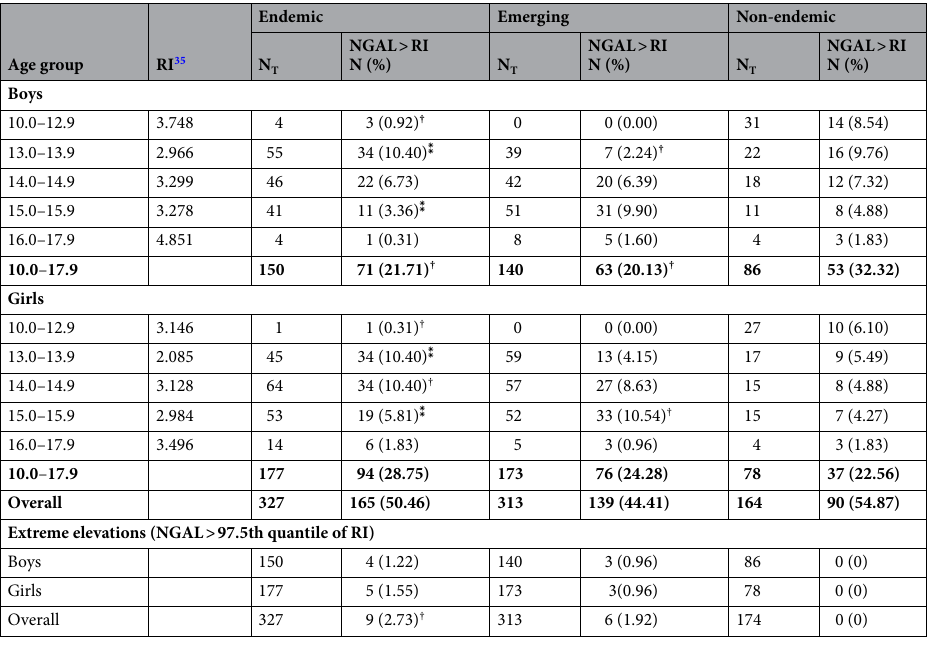
Table 4. The incidence of elevated expression of of urinary NGAL in children from CKDu endemic, emerging and non-endemic regions in Sri Lanka. The reference interval and the median NGAL of each age stratum are given for each age group. The number of children in each age stratum with urinary NGAL levels above the RI (50th quantile at 90% CI) given in the previous study 35 , for that particular age group is given as N along with its percentage with respect to the total size of the respective study group, endemic, emerging or non-endemic. Similarly, the number of children with urinary KIM-1 levels above the 97.5th quantile of RI are given as extreme elevations. Comparison of proportions of children above the RI is expressed according to Chi-squared test and for the age strata with (N < 20), Fisher’s exact test was used for comparison. ⁑ Denotes significance compared to the counterparts of same age in emerging group ( p < 0.05) and † denotes significance compared to the counterparts of same age in non-endemic group. RI reference intervals of biomarkers, N T total number of children in an age stratum within the study group, NGAL: neutrophil gelatinase-associated lipocalin.